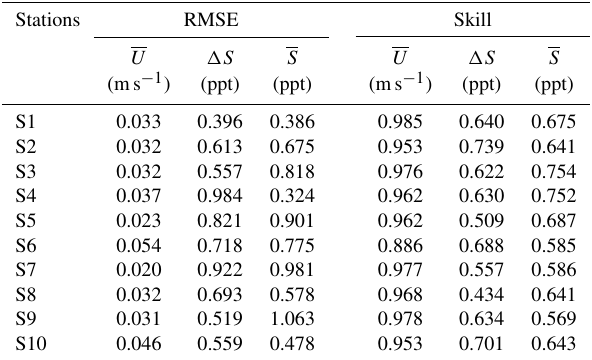
Table 2. Comparison between model results and observation in November